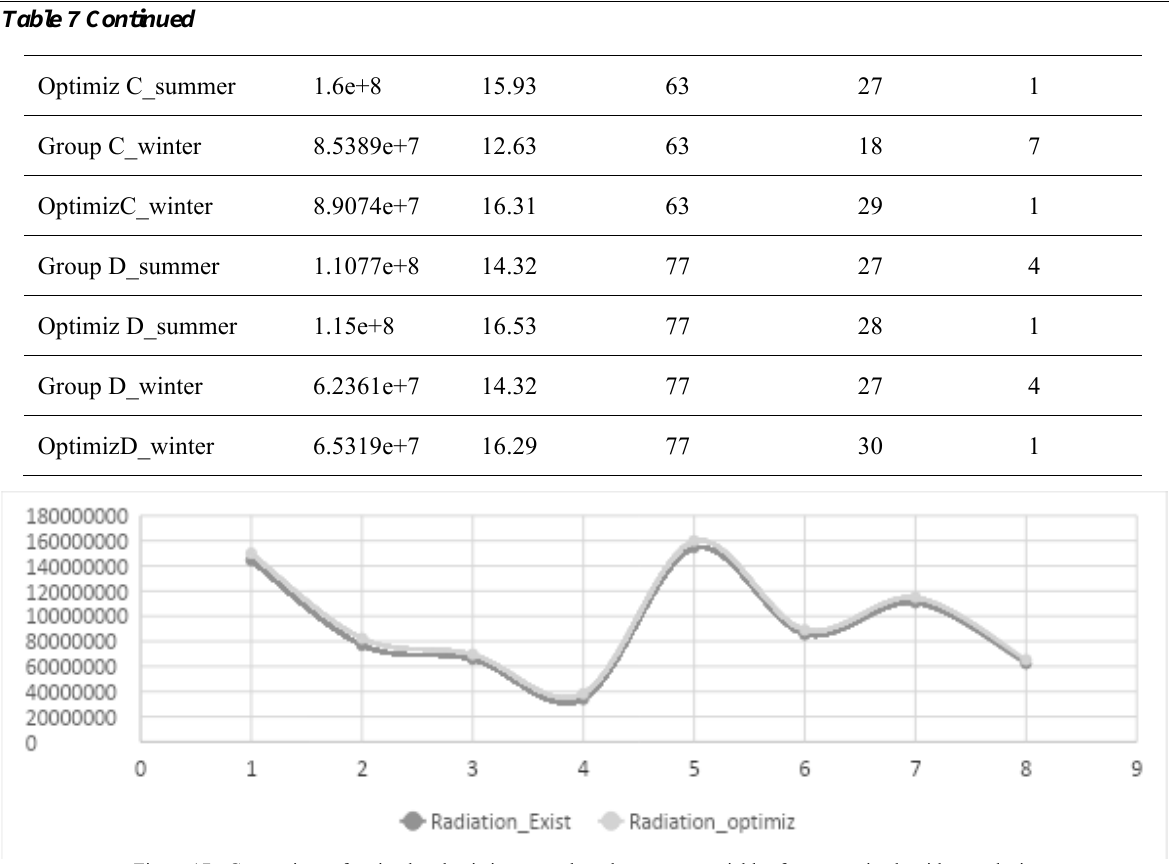
Figure 17 - Comparison of optimal and existing states based on output variables from genetic algorithm